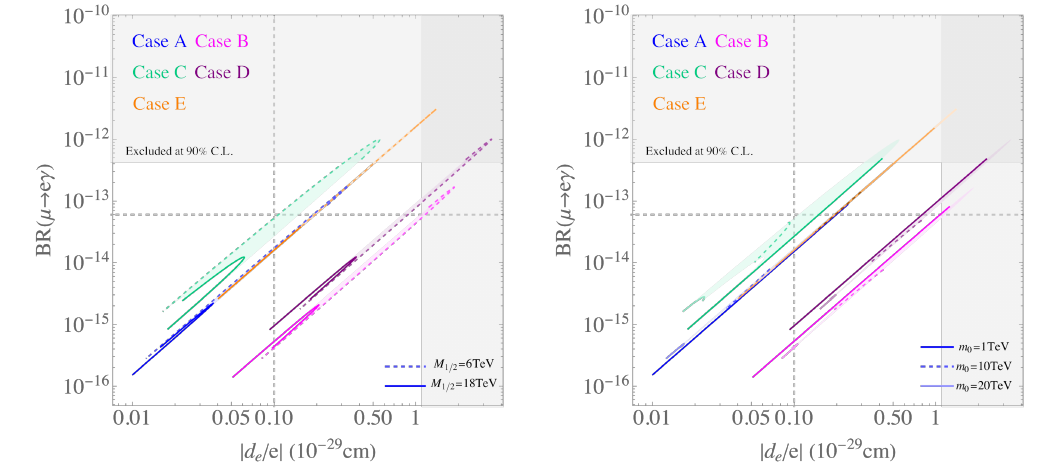
Figure 7 . Plot of | d e /e | and BR( µ → eγ ) for all Figure 8 . Plot of | d e /e | and BR( µ → eγ ) for all cases with F τ = m 0 / 2 , where m 0 = 1 – 20 TeV for cases with F τ = m 0 / 2 , where M = 6 – 18 TeV 1 / 2 fixed M = 6 and 18 TeV. The blue curves de- for fixed m 0 = 1 , 10 and 20 TeV. The blue curves 1 / 2 notes the predictions at fixed gaugino mass M denotes the predictions at fixed m 0 for case A, 1 / 2 for case A, and the same for other cases. The and the same for other cases. The grey regions grey regions are excluded by the experimental are excluded by the experimental upper bounds, upper bounds, and the vertical and horizontal and the vertical and horizontal dashed grey lines dashed grey lines indicate the future sensitivity. indicate the future